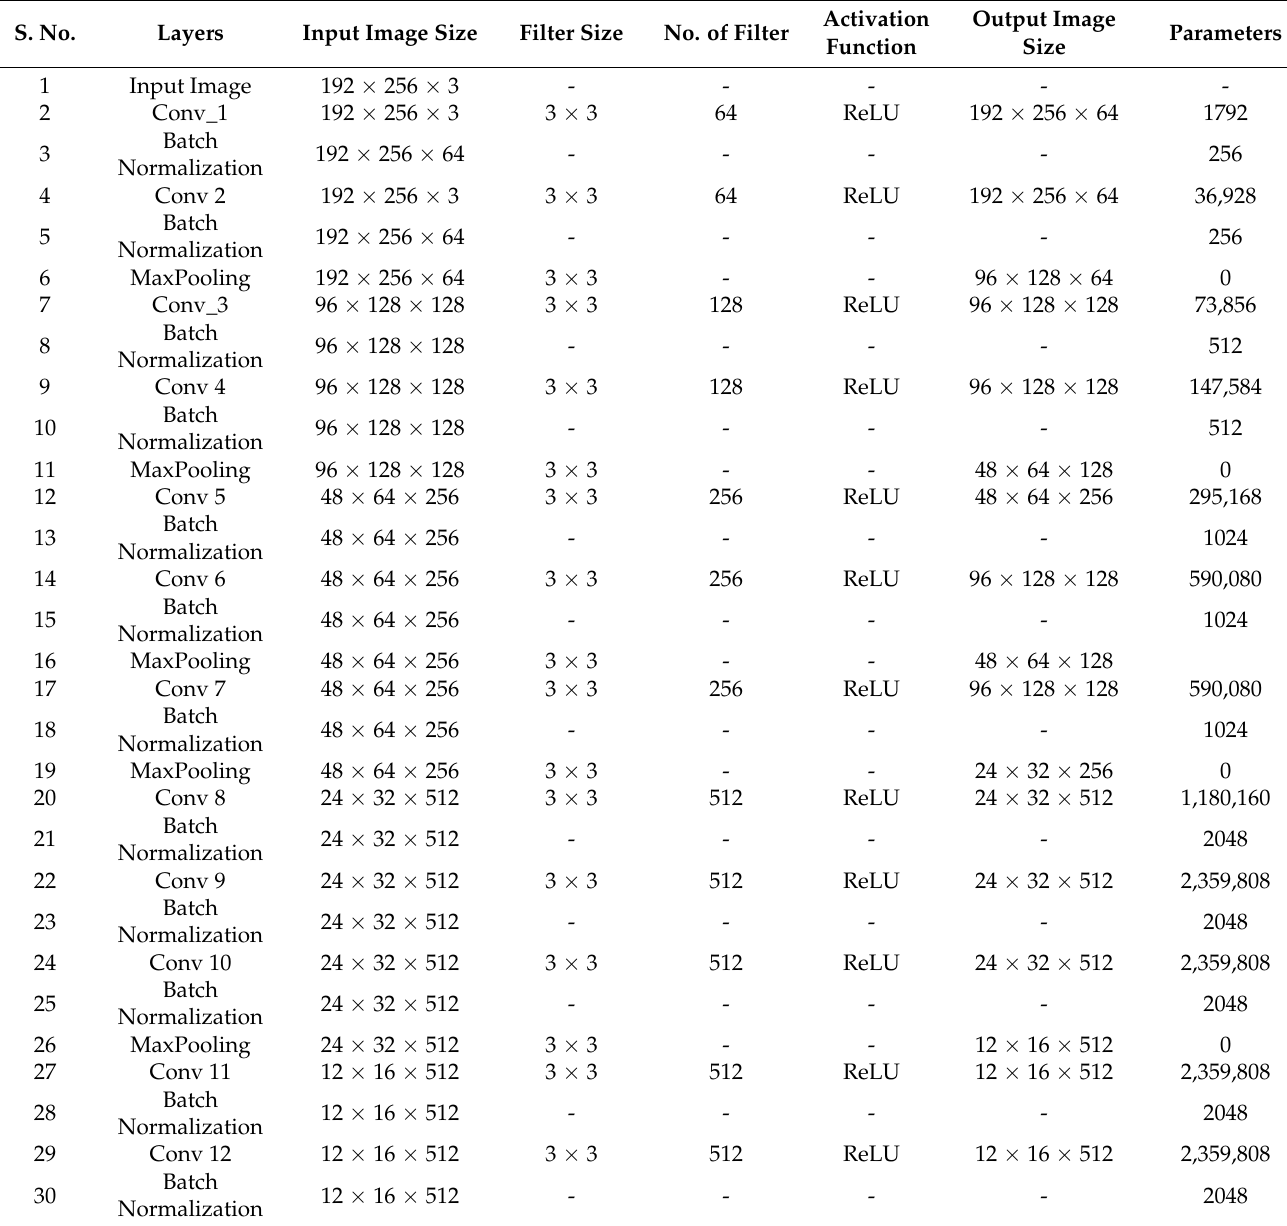
Table 1. Parameters of the Proposed